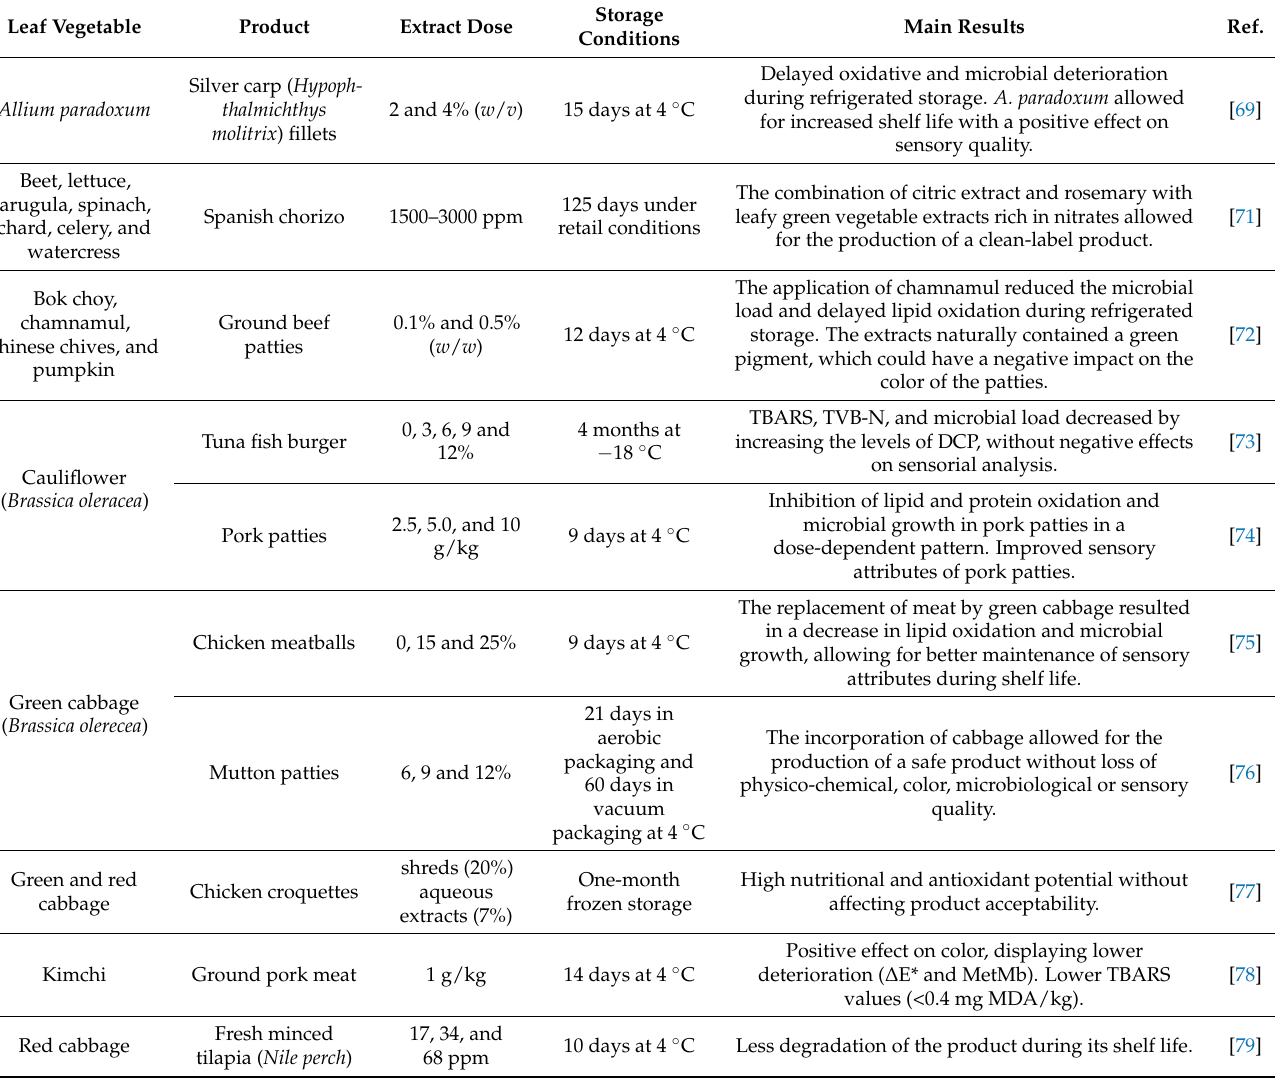
Table 2. Effect of natural extracts obtained from the leaves of different endemic plants on the shelf life of muscle